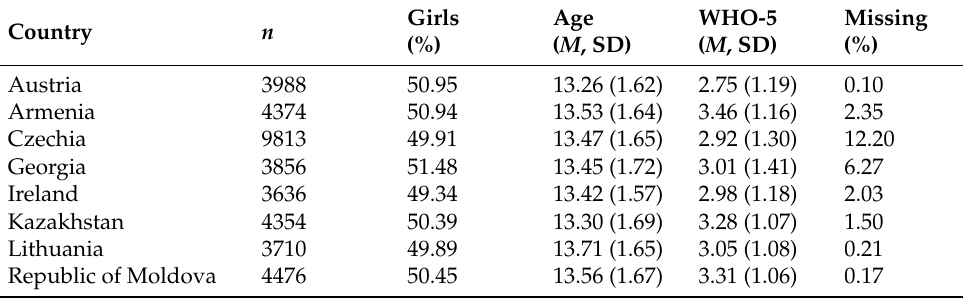
Table 1. Demographics, WHO-5 score, and sample size by country ( N = 74,071).